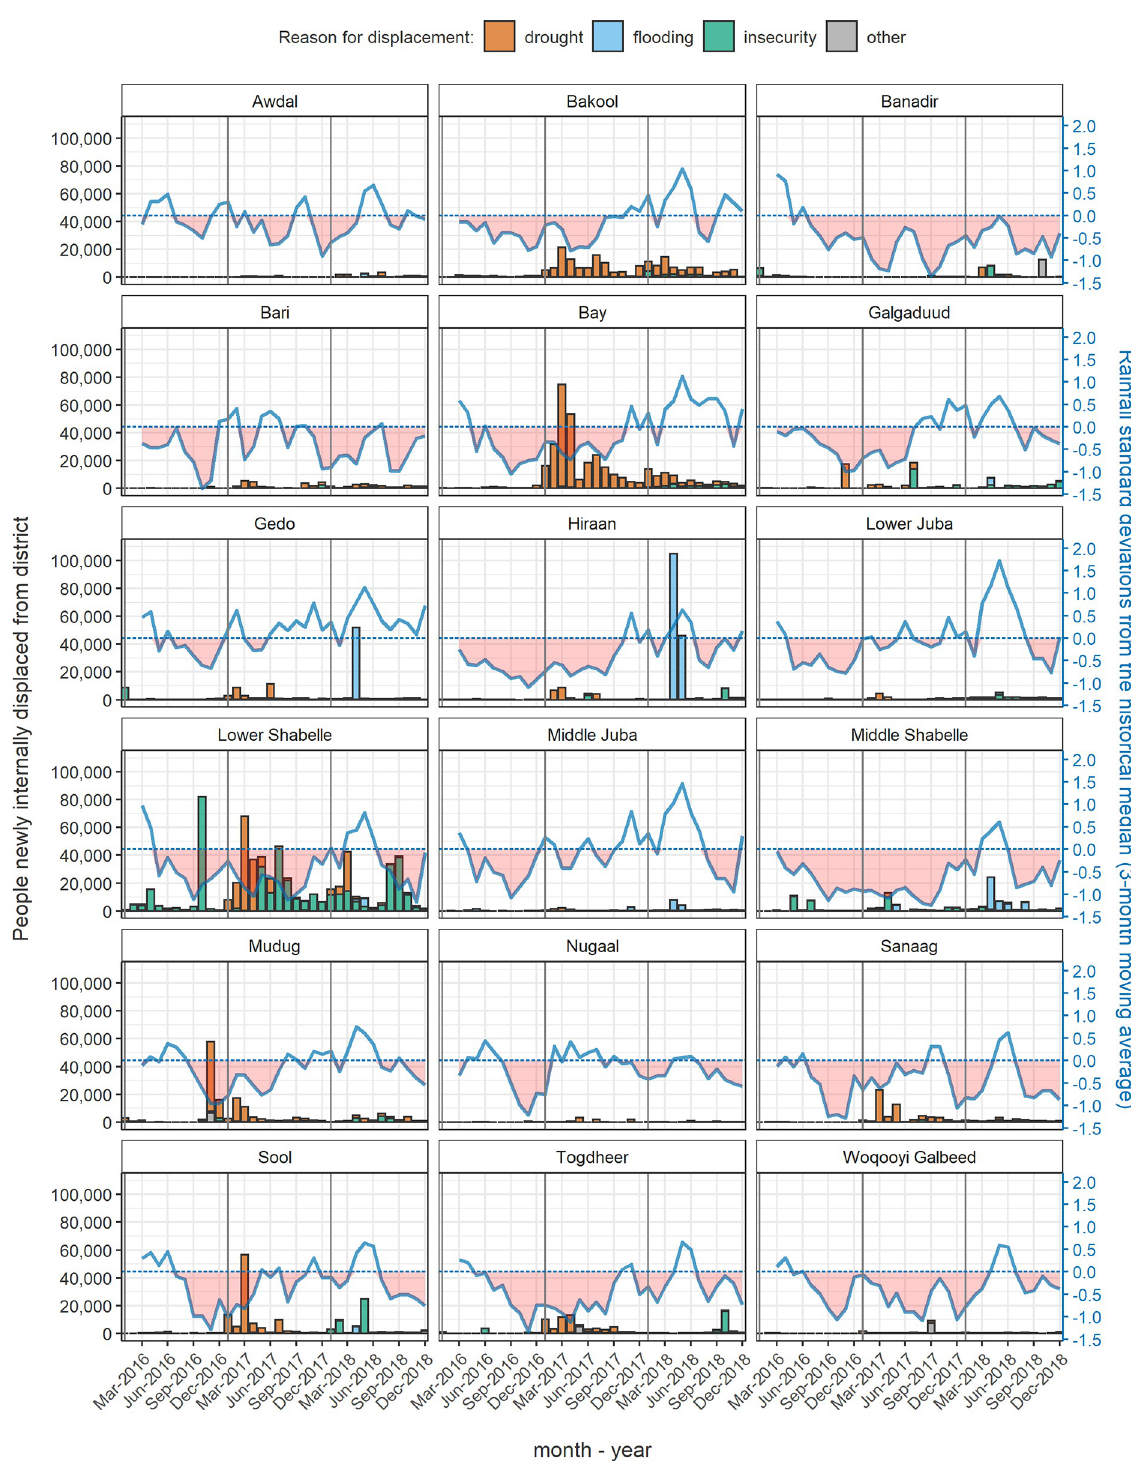
Fig 1. Rainfall levels compared to the historical average (dotted line) and number of people newly displaced (bars), by region of Somalia, 2016–2018. See Methods for data sources.